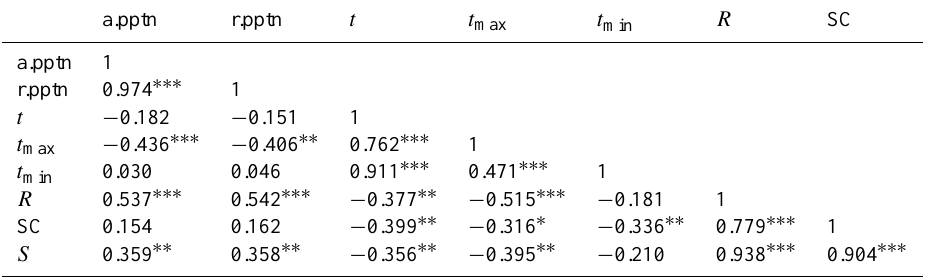
Table 3. Linear related coefficients between precipitation (pptn), runoff ( R ), sediment concentration (SC) and sediment load ( S ) of Yan River in 1952–2010.